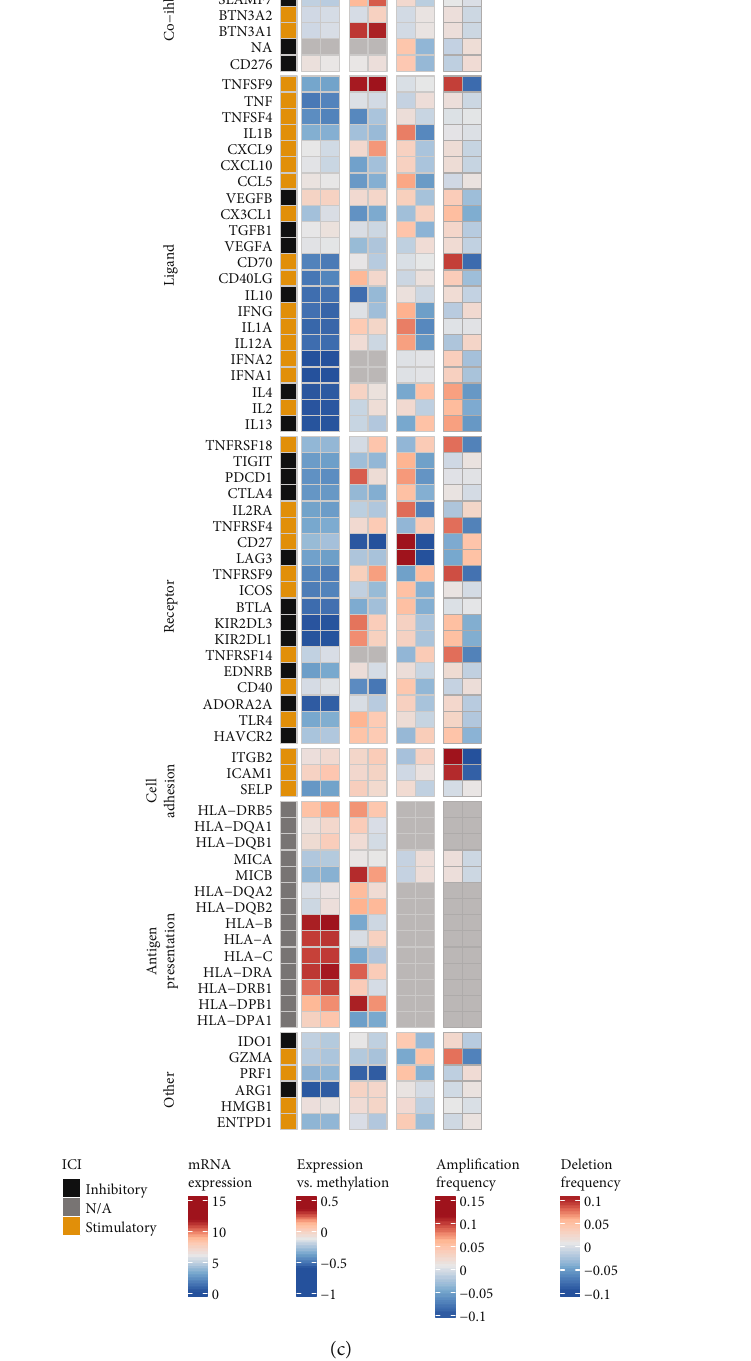
Figure 6: Implication of the cuproptosis-relevant lncRNA signature in immunotherapy. (a) The abundance levels of tumor-in fi ltrating immune cells calculated by diverse computational approaches in low- and high-risk subsets. (b) Expression patterns of immune checkpoints, cytolytic activity- and IFN- γ response-relevant markers across low- and high-risk subsets. (c) Landscape of mRNA expression, expression vs. methylation (mRNA expression correlated to DNA-methylation β values), ampli fi cation, and deletion frequencies for immunomodulators in low- and high-risk